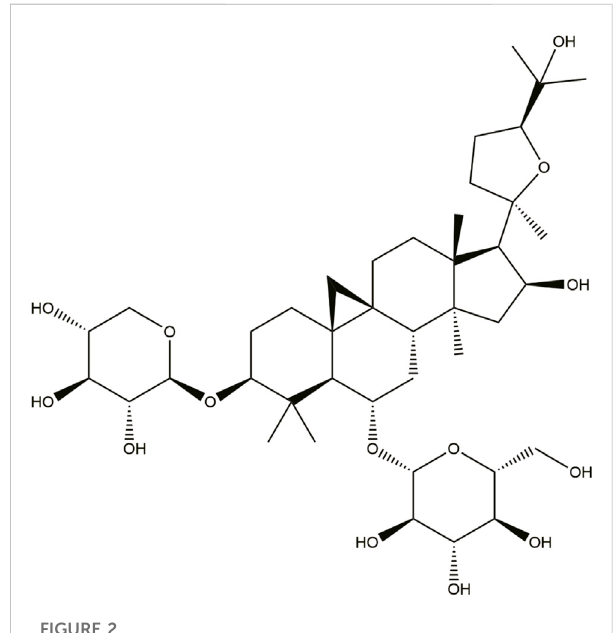
FIGURE 2 Chemical structure of Astragaloside